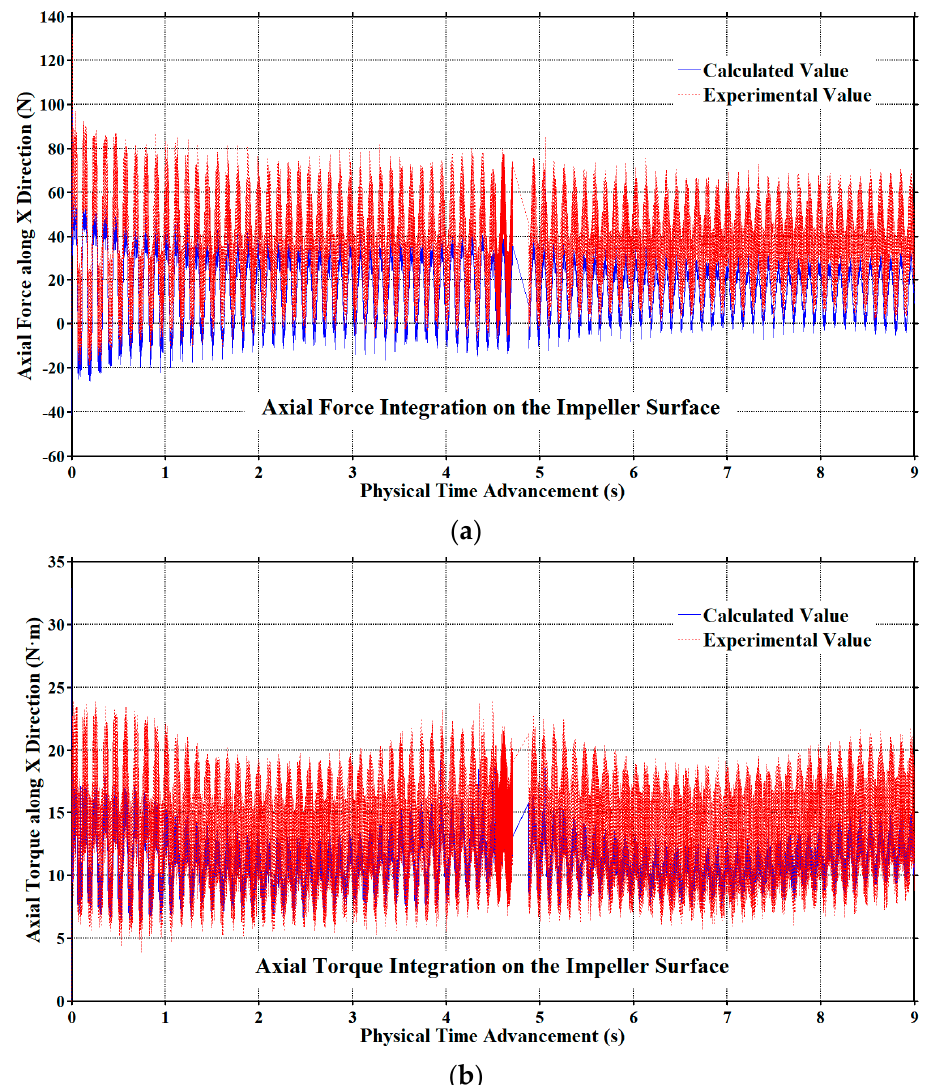
Figure 14. Overall historical values for force and torque on the impeller surface along the X direction, in which ( a ) represents the change of axial force, and ( b ) refers to the change of axial torque. In the wake flow calculation of the CFD model, the overall air force and torque along X direction are integrated on the surface of the impeller by an interval of each time step, which relies on a series of lattices that are organized in an octree-structure algorithm. The specific boundary setting of the calculation model and related theory refers to the content of Section